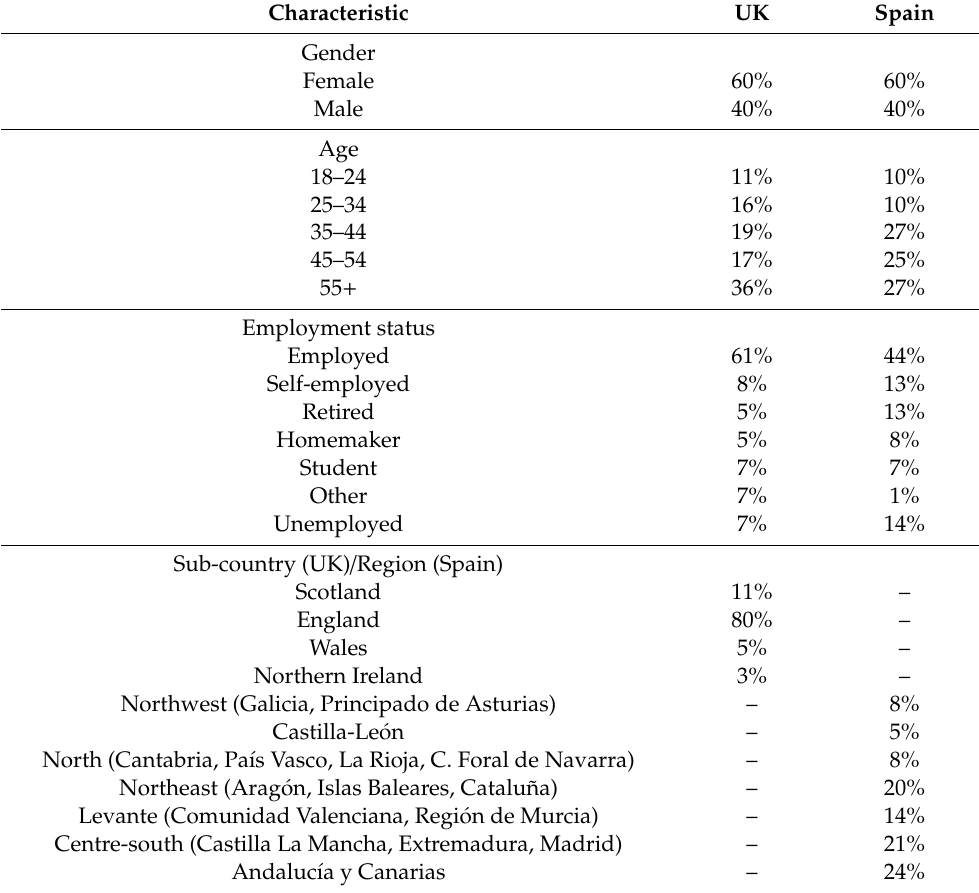
Table 1. Respondents’ sociodemographic